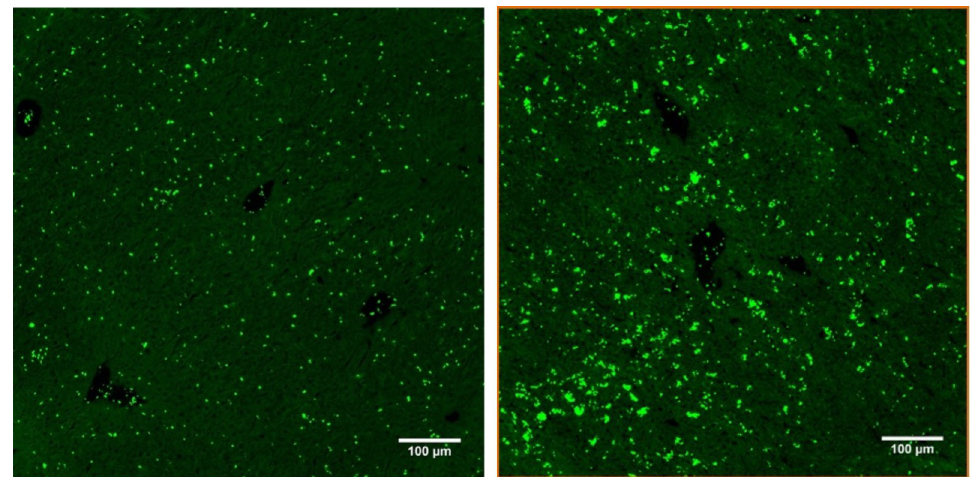
Fig 7. Immunohistochemical staining of frozen liver sections 20 h after CASP with anti-CD42c � FITC/Alexa 488. Depicted are representative results of frozen sections from 8- to 10-week-old C57Bl/6 liver tissue with immunohistochemistry staining of platelets (green dye) with anti-CD 42c antibody � FITC/Alexa 488. The left row shows only a few platelets uniformly distributed in the liver tissue of untreated animals (a), while the right row shows platelet accumulation and aggregates in the liver tissue 20 h after CASP surgery (b); (scale bar 100 μ m, negative control not shown, quantification of the r esults shown in Fig 8).